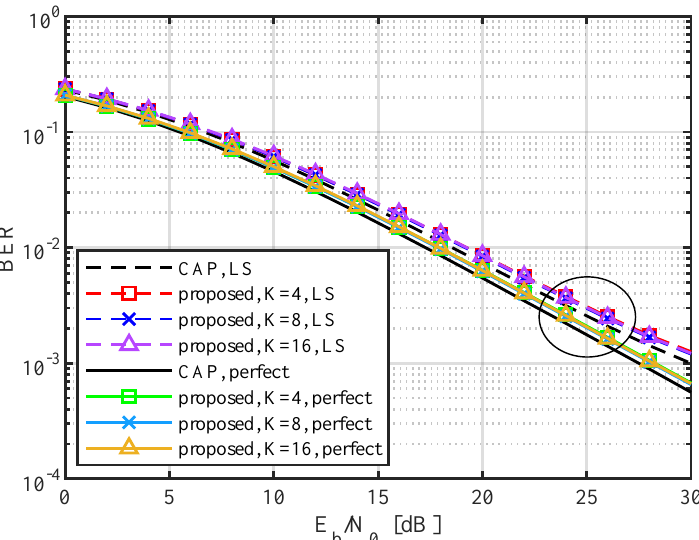
Figure 6. BER performances when the LS channel estimation method is adopted (broken line) and when channel state information is known perfectly (solid line). Note that c = 0.15 is adopted in